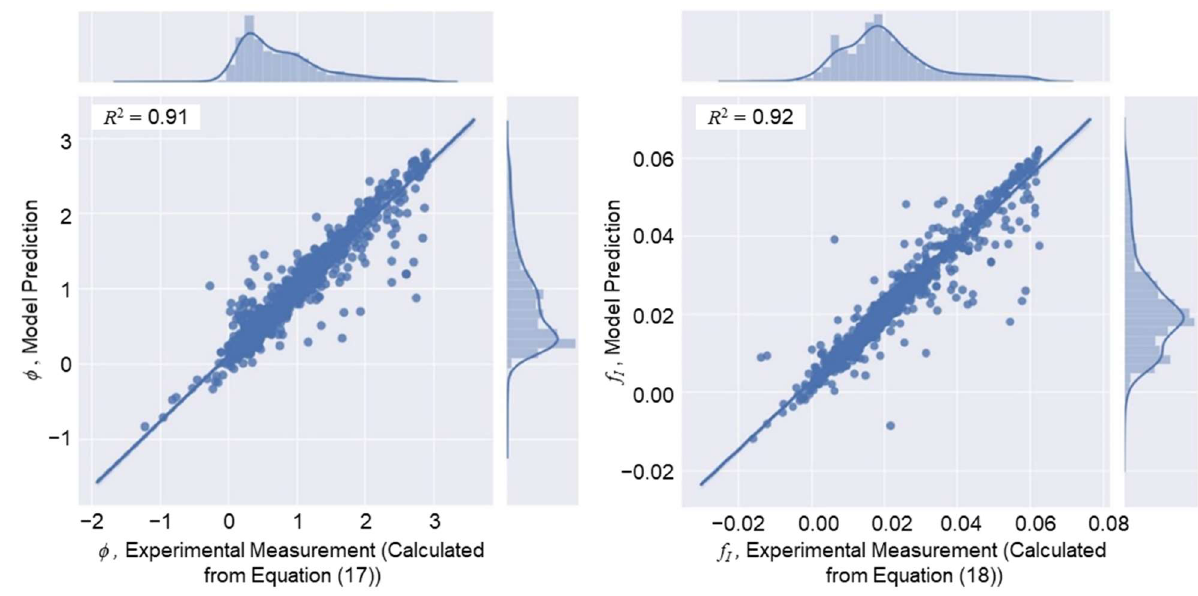
Figure 7. Prediction performance using XGBoost as an algorithm for ϕ and f I .